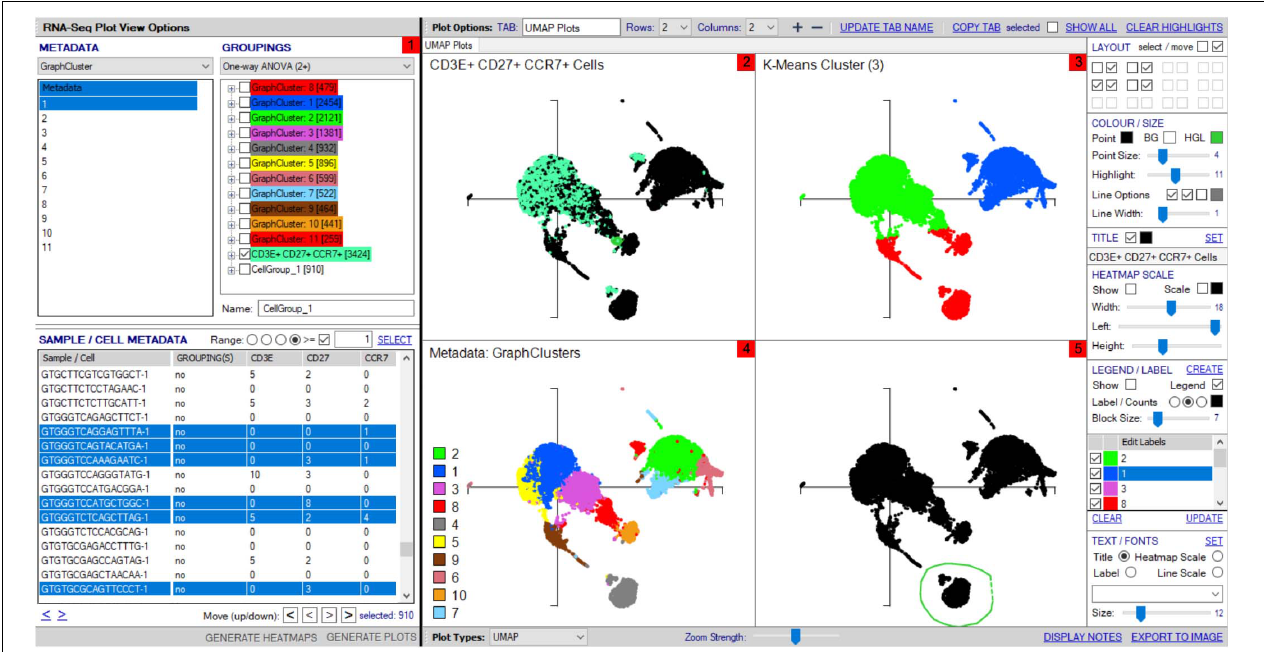
FIGURE 6 | Multipanel UMAP investigation. (1) Sample/cell groupings created in “Groupings” panel can be plotted on multipanel UMAPs, with zoomed view possible to focus on different regions of interest (2–5). (2) Groupings created from differentially expressed genes and metadata can be highlighted within the total cell population, shown for CD3E + CD27 + CCR7 + cells group defined in panel 1. (3) K-means clustering can be set in the scRNA-seq Plot View Options window and illustrated within UMAP. (4) Cell types from unsupervised clustering can be separately colored on a UMAP with legend for visualization. (5) Cell clusters can be “lassoed” on the UMAP and highlighted within the “Sample/cell metadata” grid for addition to distinct groups within “Groupings” for further analyses, named “CellGroup_1” in groupings tab.